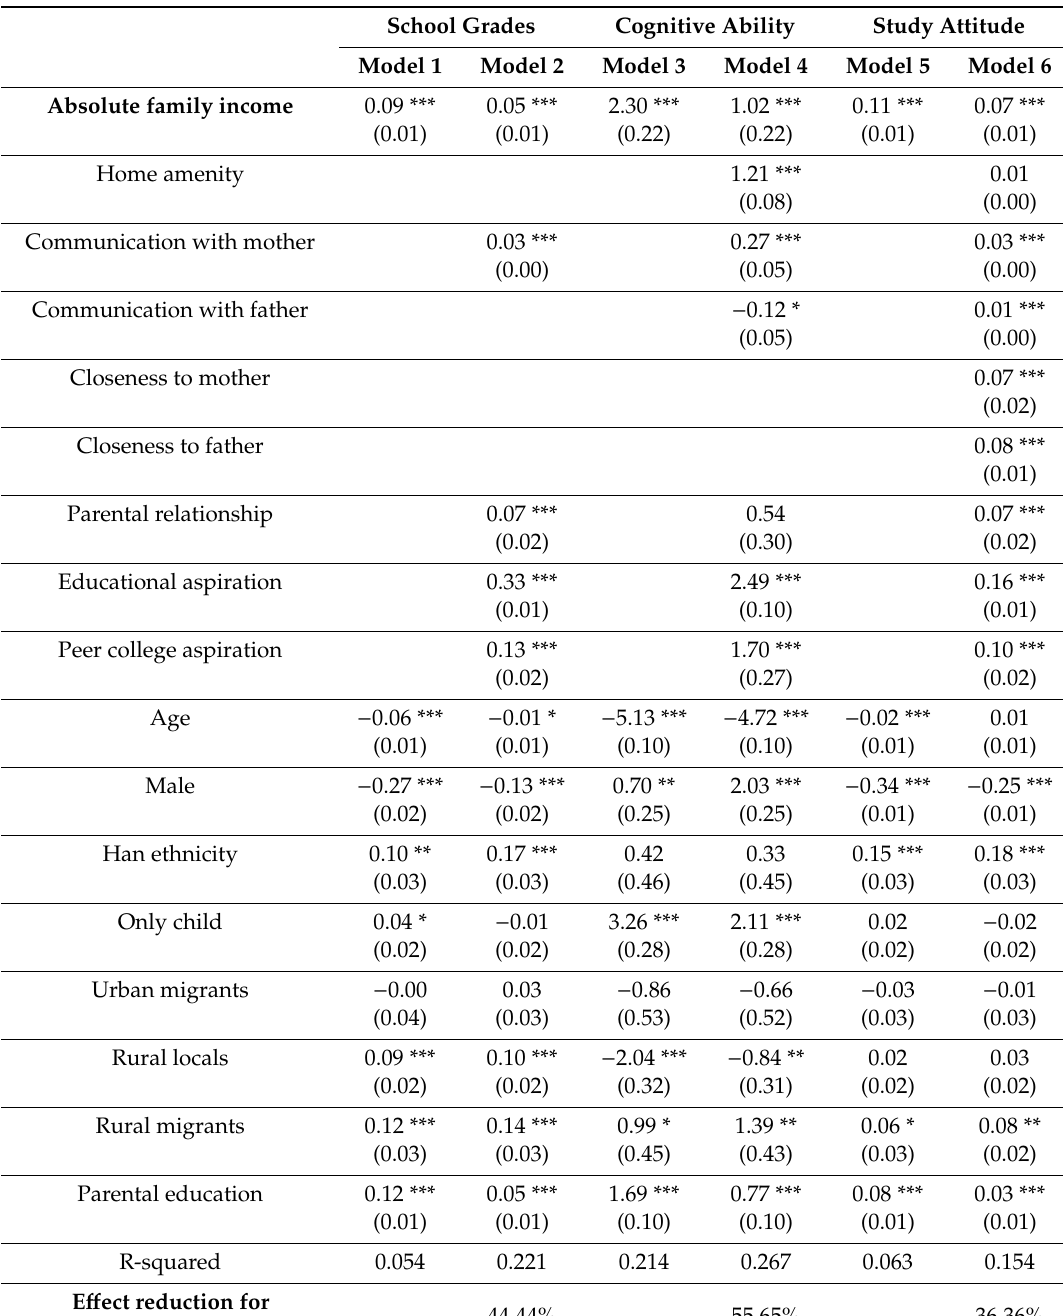
Table 5. Mediating E ff